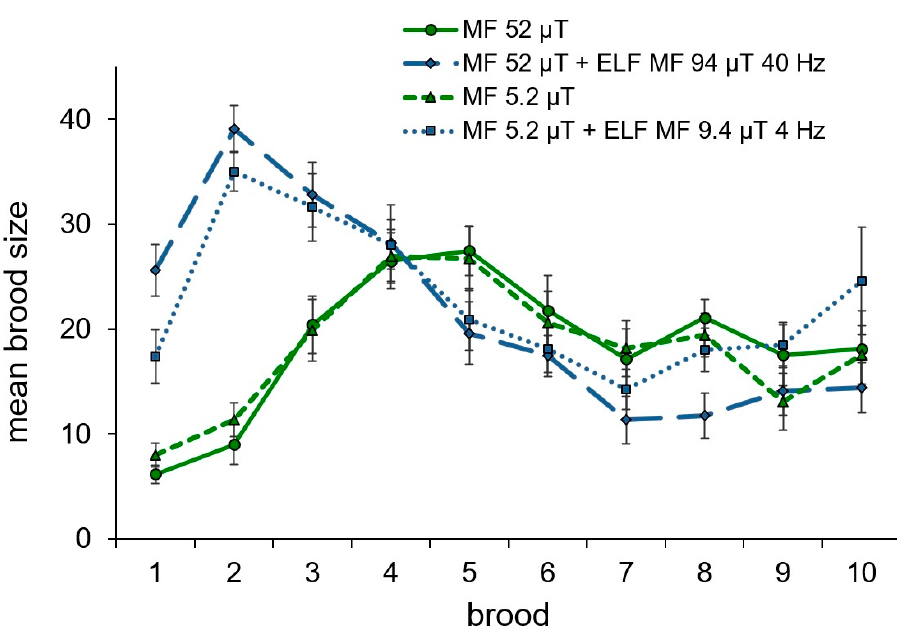
Figure 2. Dynamics of changing mean brood size (ind.) in the in the groups of D. magna exposed to studied magnetic fields. Bars denote standard error.